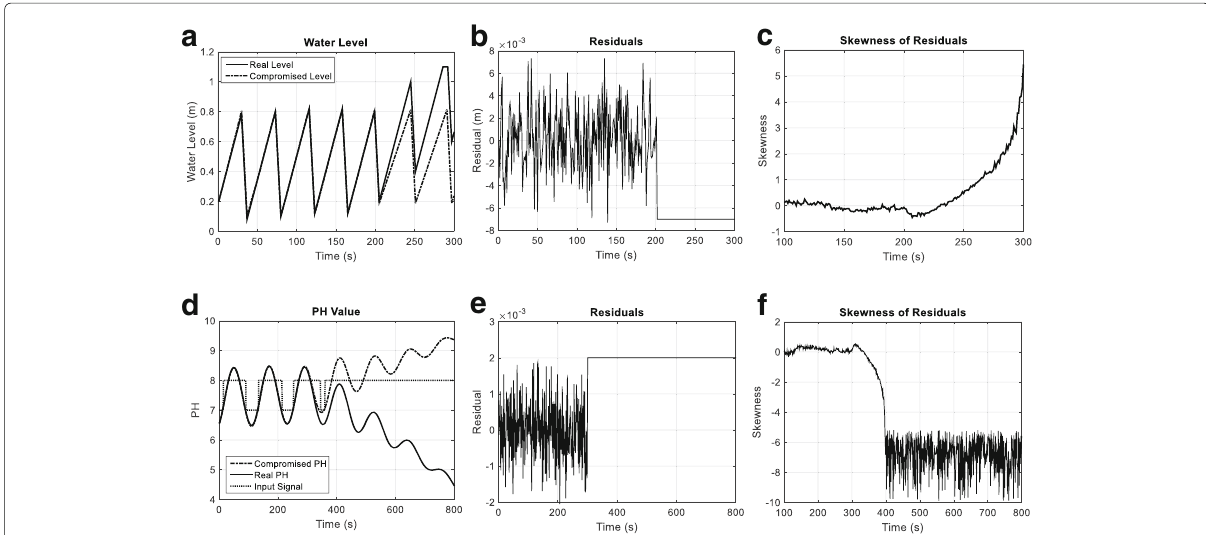
Fig. 7 Detection of surge stealthy attacks. When the surge stealthy attacks in ( b ) and ( e ) are conducted on the water level control system and the pH value control system, respectively, the real water level shown in ( a ) deviates significantly from the seemingly normal but compromised water level, and the real pH value shown in ( d ) also deviates observably from the seemingly normal but compromised pH value. The significant changes of skewness coefficients of residuals shown in ( c ) and ( f ) indicate that the approach proposed can identity surge stealthy attacks